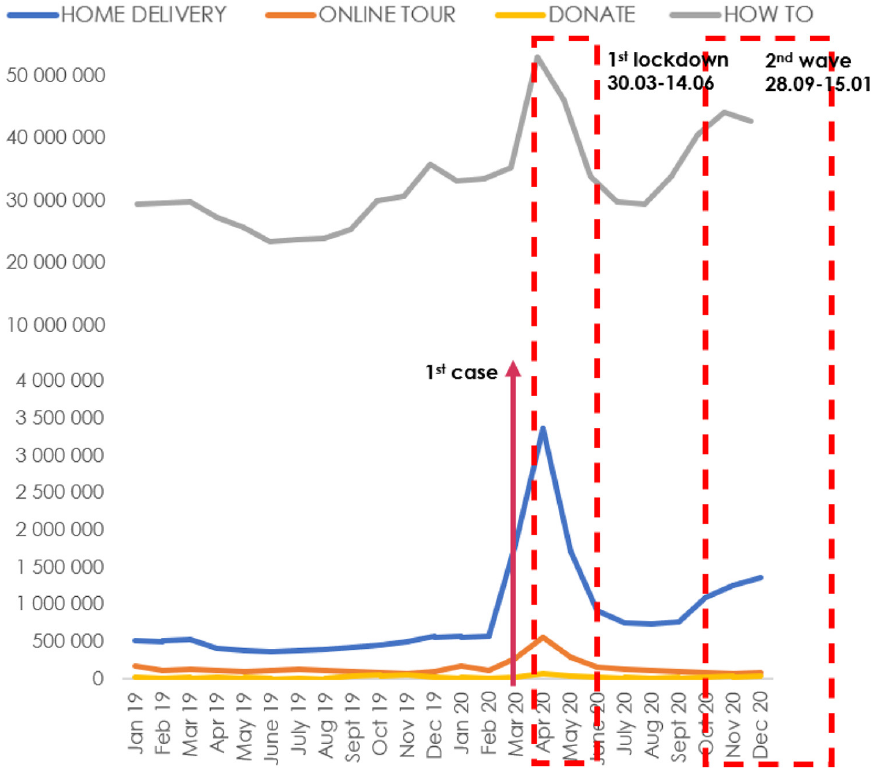
Figure 1. Dynamics of search activity of Russian consumers in 2019–2020. Source : compiled by the authors according to Yandex WordStat , 01.01.2019 —